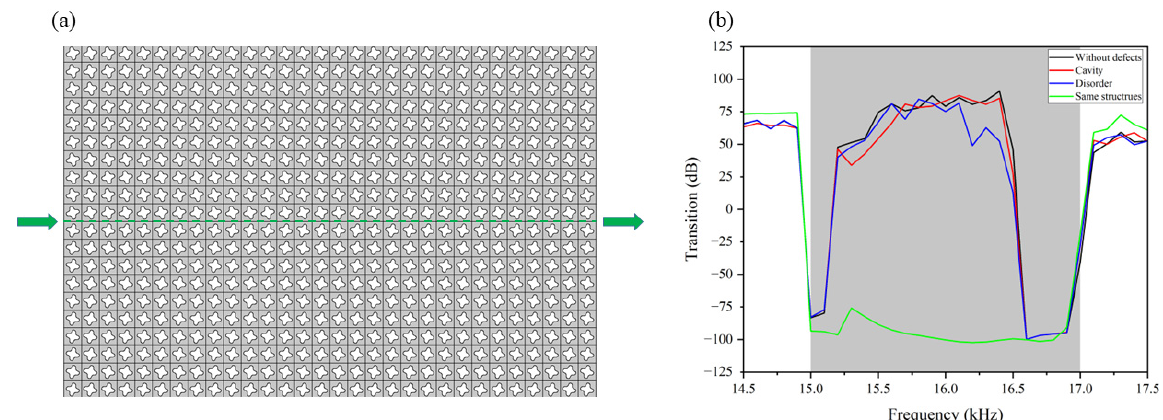
Figure 5. ( a ) Schematic diagram for the investigation of transmission properties. ( b ) Transmission spectra of different structures. The green line represents the trivial design consisting of only one type of insulator (crystal A). The black, red, and blue curves represent the structures consisting of a pair of different insulators with no defects, with cavities and with disorders, respectively. different insulators with no defects, with cavities and with disorders,